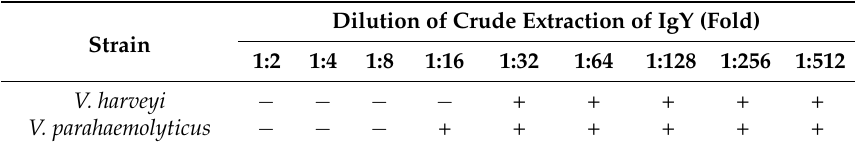
Table 1. The inhibitory effect of specific IgY on V. harveyi and V. parahaemolyticus. Dilution of Crude Extraction of IgY (Fold) Strain